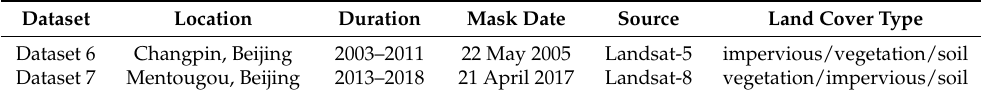
Table 5. Real data experiments’